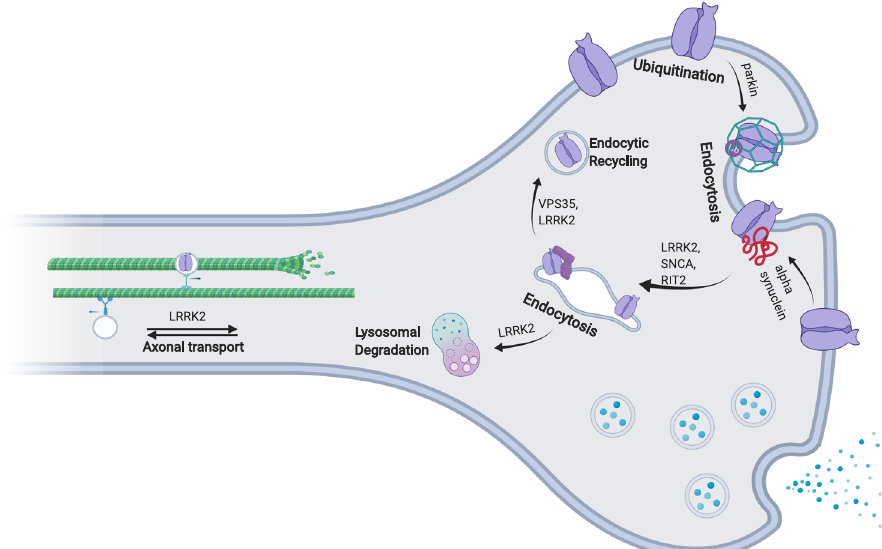
Fig. 2 A model for the physiological and pathological roles of PD-lined genes in DAT regulation. Dopamine transporter traf fi cking is regulated by various mechanisms, many of which overlap with key molecular mechanisms compromised by PD-linked mutations. α -synuclein and Rit2 interact with DAT and regulate both surface expression and dopamine uptake kinetics. LRRK2 may regulate DAT traf fi cking either through axonal transport and/or endocytic traf fi cking. Parkin is proposed to ubiquitinate improperly folded DAT and increase its turnover rate. VPS35 is responsible for recruiting internalized DAT to a recycling fate. This fi gure is created with